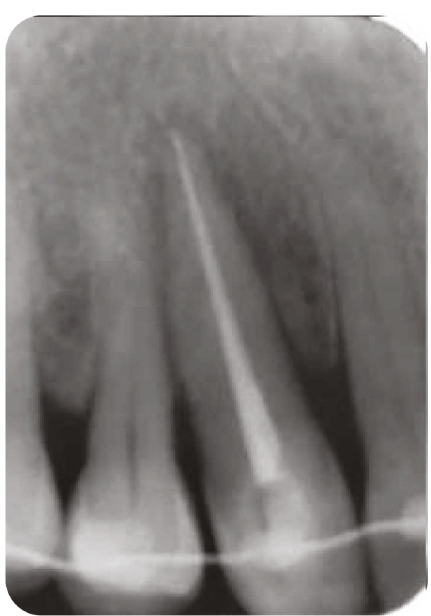
Figure 13: 39 months ’ recall radiograph showing a bone